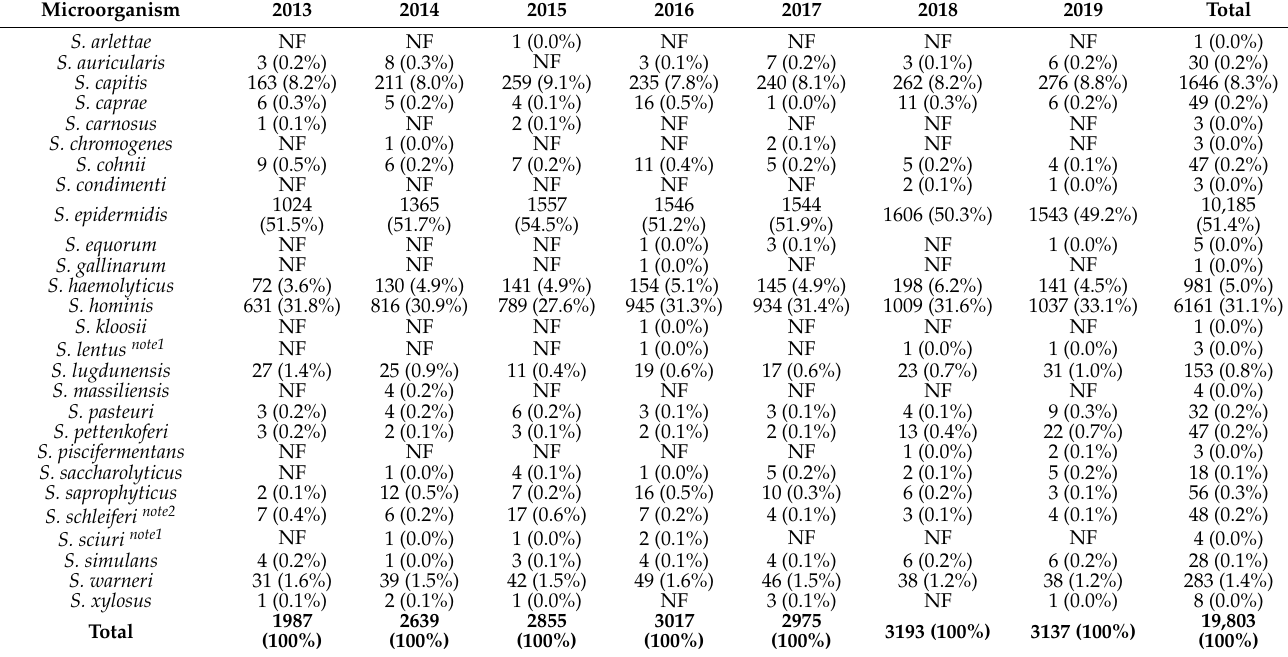
Table 2. Overview of the total number of isolated CoNS species (not only first isolates) found between 2013 and 2019 in the Northern